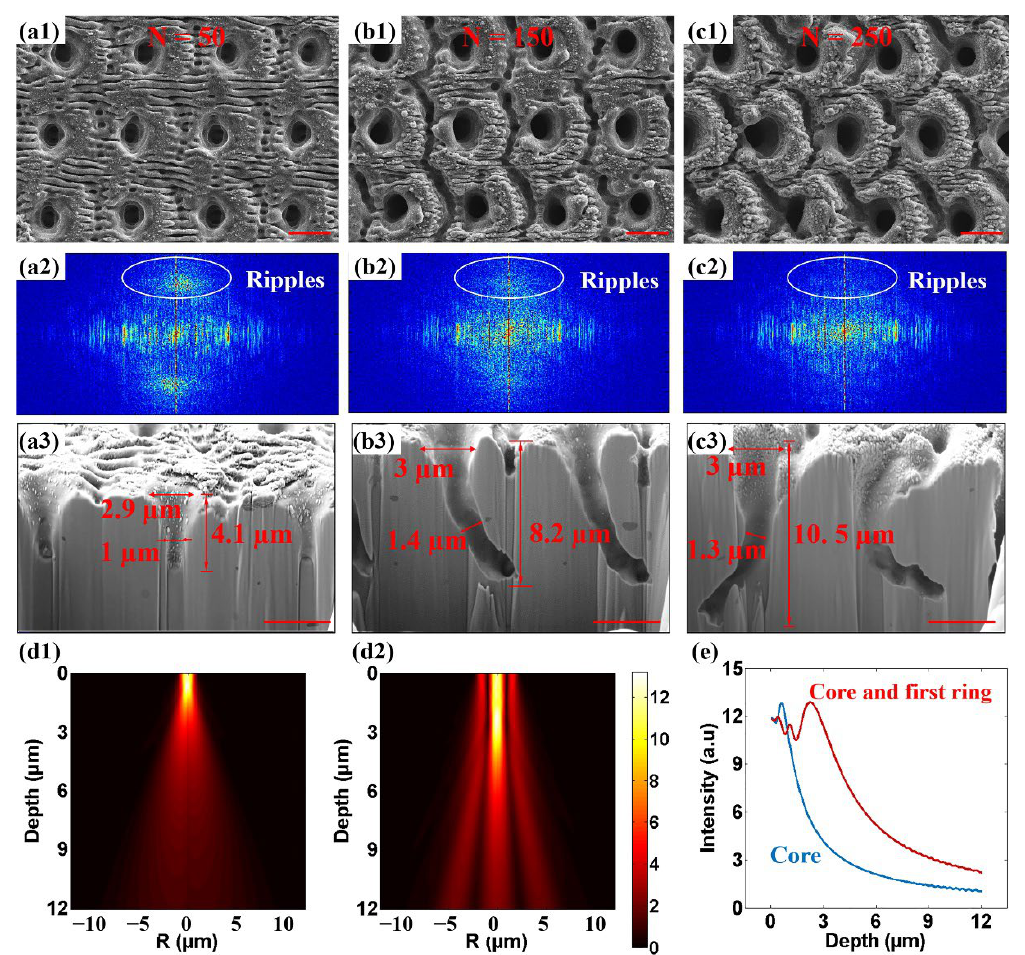
Figure 3. Surface morphologies of NiTi alloy under the action of burst Bessel beam with high N and Fourier transformation of SEM LIPSS–pit structure. ( a1 – c1 ) Surface morphologies of NiTi alloy under the action of burst Bessel beam with ( a1 ) N = 50, ( b1 ) N = 150, and ( c1 ) N = 250. ( a2 – c2 ) 2D Fourier transformation of the SEM porous structure in ( a1 – c1 ). ( a3 – c3 ) Cross-sectional SEM of porous structure in ( a1 – c1 ). ( d1 – d2 ) Blocked Bessel beam propagation ( d1 ) core only and ( d2 ) the core and first ring of the Bessel beam. ( e ) Variation curve of Bessel beam intensity with depth of different orders. (Scale bar = 4 µm) .